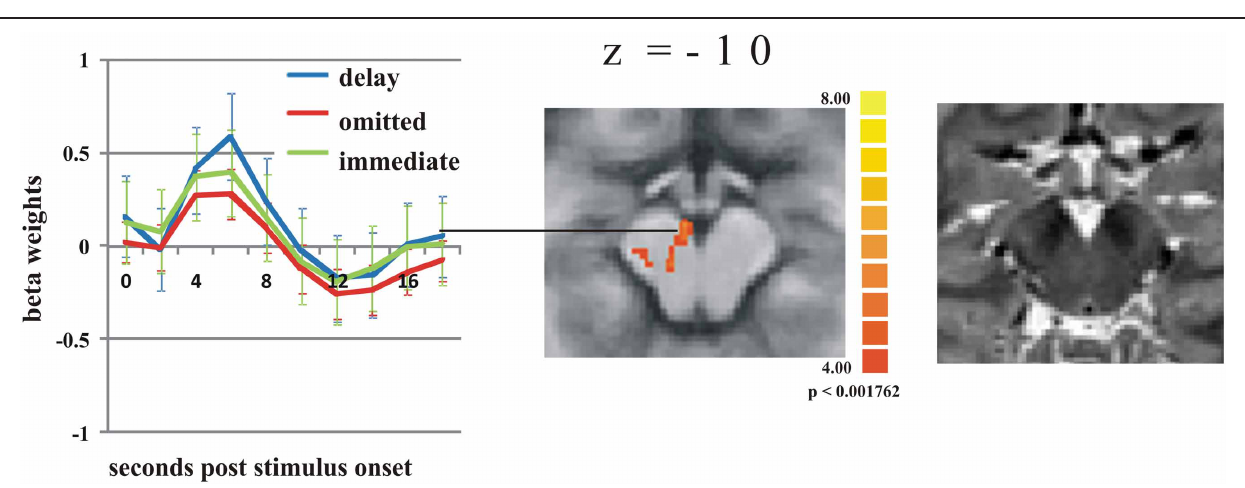
(see Table 3 for statistical ROI analysis). Error bars indicate SEM. The T2 weighted image of the SN/VTA regions on the right site clearly shows the dark regions of SN.